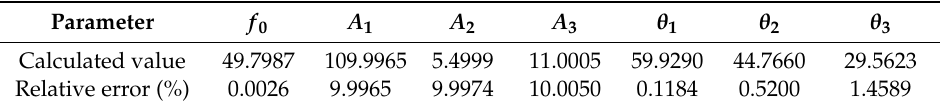
Table 1. Identification and errors of harmonic parameters of the oblique envelope signal.